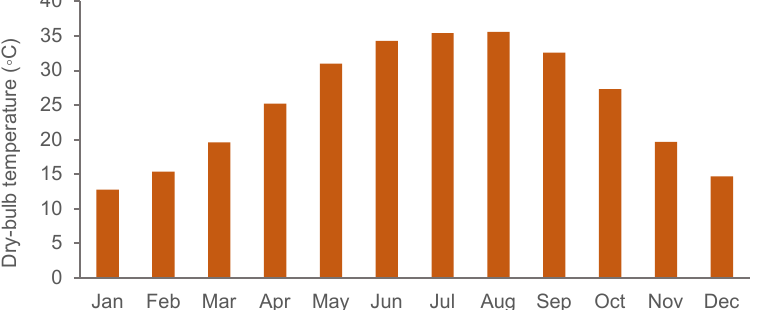
Figure 3. Average monthly temperatures for Qassim region (Source: GAMEP met. Station, 2016). Table 2. Material properties of building